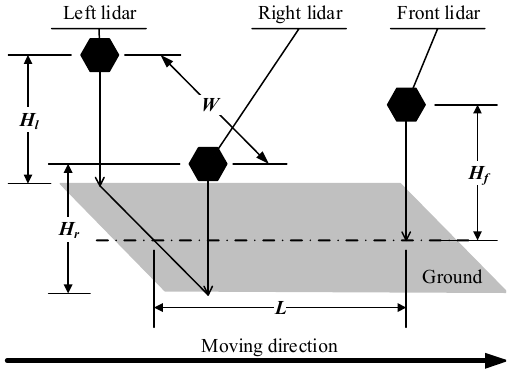
Figure 3. Illustration of lidars installation.